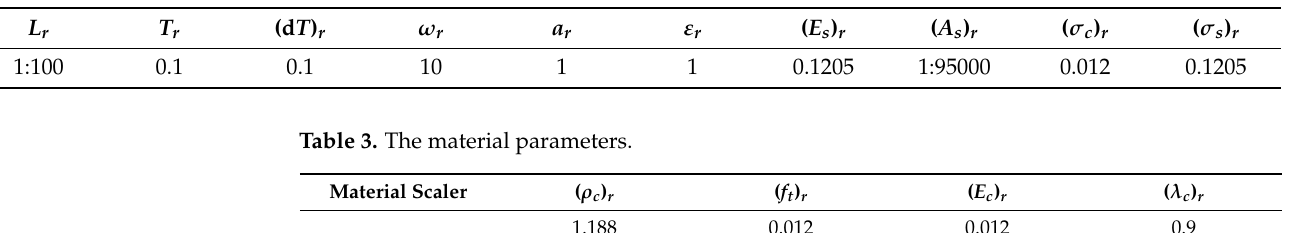
Table 2. The scale factors included in the seismic response analysis.